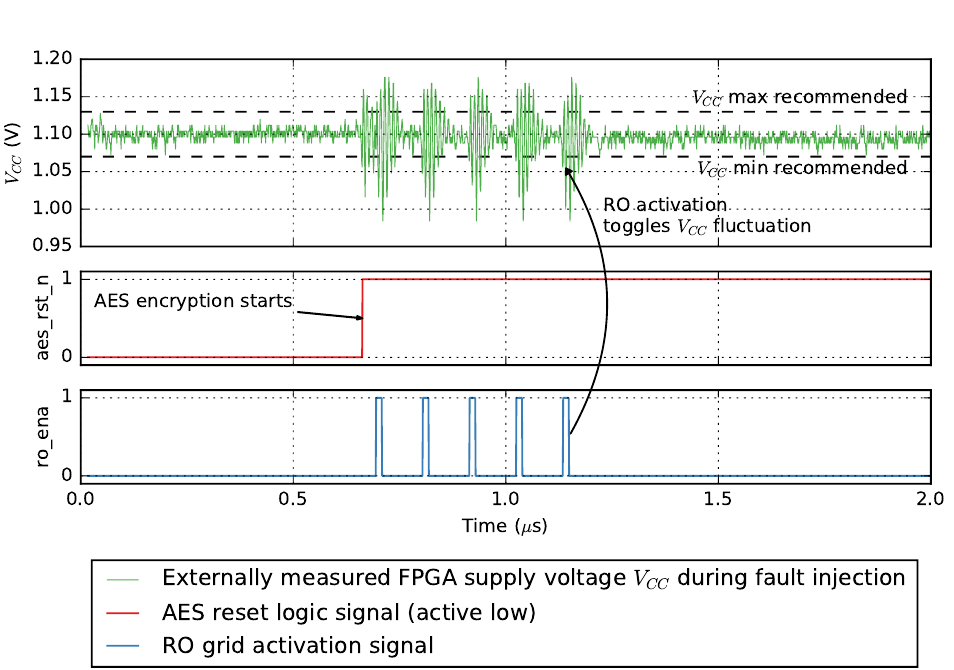
Figure 9: Trace of FPGA supply voltage VCCINT , measured externally with an oscilloscope during a single fault injection attempt d) If the injection was successful or a predefined maximum of injection attempts inj were unsuccessful, the attacker software deactivates the RO grid and either finishes the successful scan or chooses another random plaintext for fault